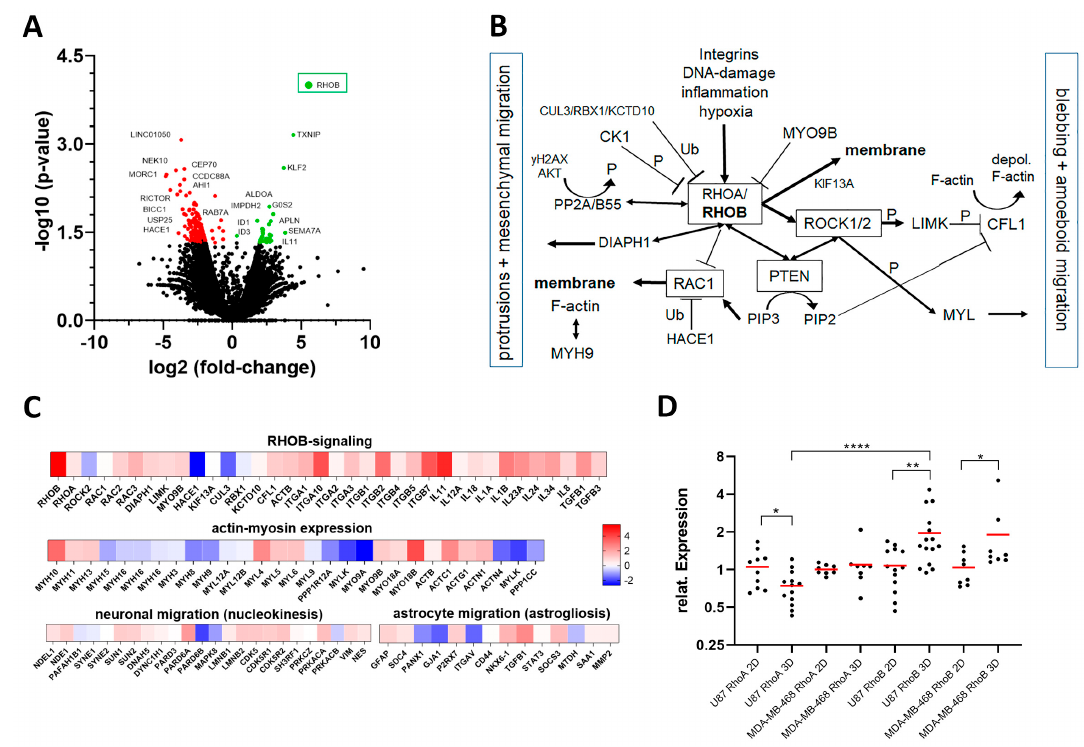
Figure 5. RHOB signaling and regulation of migration. ( A ) RNA-seq data (Volcano-plot) of U87 PTEN loss of function cells grown in 3D with Matrigel and scaffolds versus 2D (3 days). Red dots (left): significantly ( p < 0.05) down regulated genes; green (right) dots significantly ( p < 0.05) up-regulated genes. RHOB was 5.528-fold log2 up regulated in U87 3D cultures and scaffolds ( p = 0.0001). Other significantly up-regulated genes include G0S2 (6.4-fold, p = 0.011), induced in glioma with high invasion [55], APLN (4.55-fold, p = 0.0307) induces colon cancer cell migration [56], ALDOA (3.37-fold, p = 0.0202) promotes lamellipodia [57], SEMA7A (3.84-fold, p = 0.05) via ITGB1 [58] and IMPDH2 (1.25-fold, p = 0.036) regulates colorectal cancer cell migration [59] (Supplemental Tables S1 and S2). ( B ) Overview of the RHOB signaling pathway. RAC1 promotes an elongated cell phenotype (mesenchymal) migration (left), which is inhibited by RHOB. RHO activates ROCK leading to blebbing and amoeboid migration (right) and is negatively regulated by PTEN dephosphorylating phosphatidylinositol-3,4,5-triphosphate (PIP3) to phosphatidylinositol-4,5-bisphosphate (PIP2). Ub (ubiquitinylated); P (phosphorylated). ( C ) RNA-seq gene expression differences (heatmaps) of U87 PTEN loss of function cells in 3D with Matrigel and scaffolds versus U87 in 2D (red = log2-fold up regulated and blue= log2-fold down regulated). Top heat map: RHOB signaling genes, e.g., up-regulation of Integrins (esp. ITGA10 and ITGB2 ) and inflammation genes (e.g., IL11 , IL1B ) stimulating RHOB; middle heatmap: actin-myosin expression; bottom heatmap: neuronal migration (left) and astrocyte migration (right). ( D ) QPCR and relative gene expression (2-DDCt) of RHOA and RHOB in U87 and MDA-MB-468 PTEN loss of function cells in 2D vs. U87 and MDA-MB-468 cells in 3D with Matrigel and scaffolds (3 days). Significant values from left to right: U87 RHOA expression in 2D vs. 3D: * p = 0.0316; U87 RHOB expression in 2D vs. 3D: ** p = 0.0031, MDA-MB-468 RHOB expression in 2D vs. 3D: * p = 0.0409. U87 RHOA 3D vs. U87 RHOB 3D: **** p <